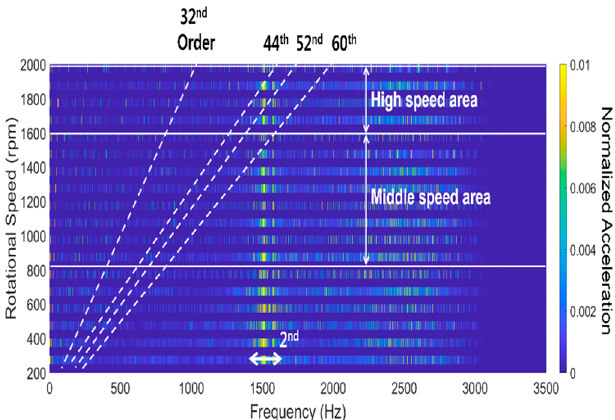
Figure 14. Waterfall graph of the electromagnetic-structural vibration coupled analysis with the simplified FE model in the operating speed range.